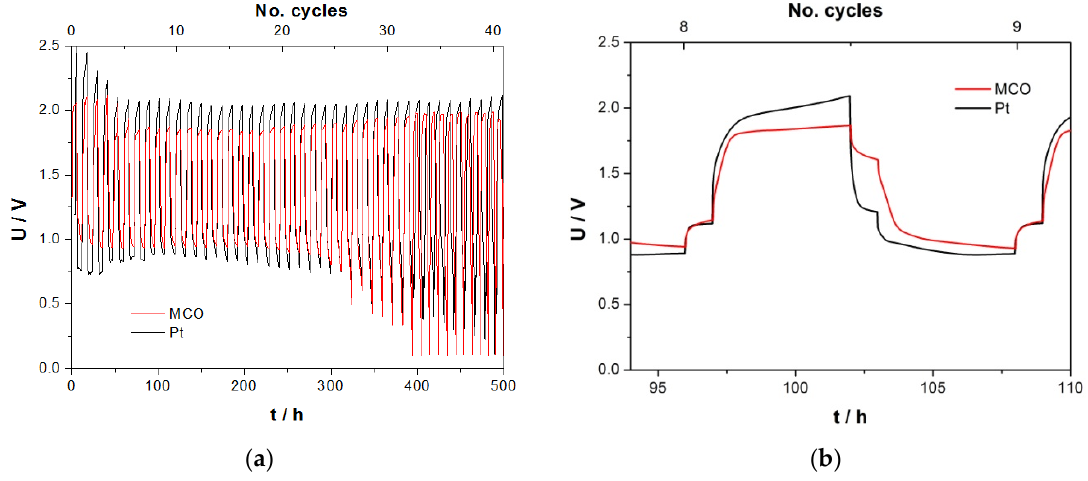
Figure 16. ( a ) Long-term stability cycle tests in zinc/air coin cell with MCO or Pt as an air electrode in ChAcO + 0.01 M ZnAcO 2 + 30% H 2 O electrolyte for 12 h per cycle (5 h charge/discharge) at 100 µAcm − 2 in ambient air (30% RH at 23°C). ( b ) Comparison of charge/discharge profile during 18th cycle. Voltage cut-off limits of 2.5 and 0.1 V.